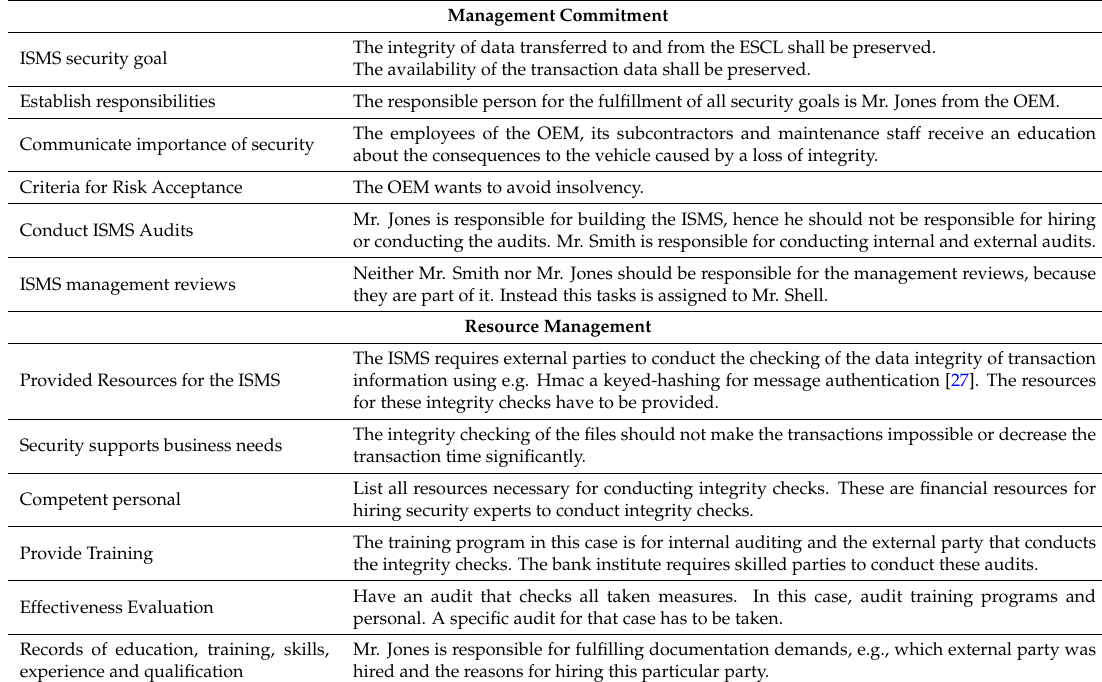
Table 5. Instantiated Template for Management Approval of the information security management system (ISMS) based on